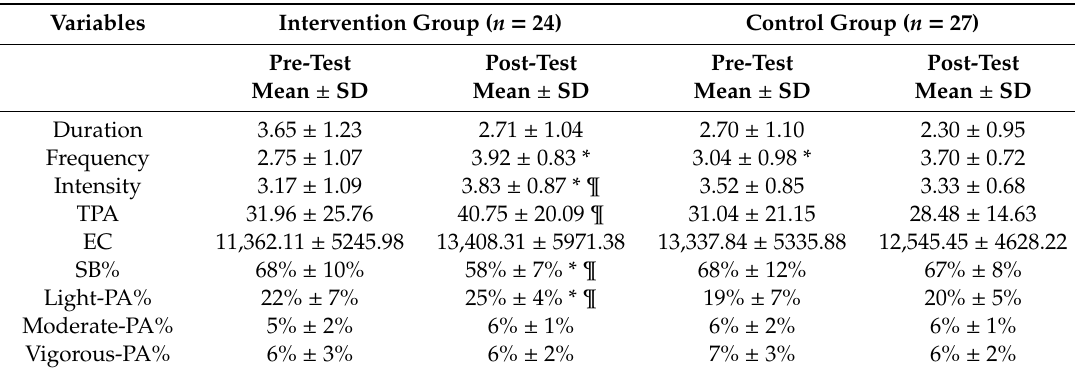
Table 4. Results of behavioral indices between the two groups at baseline and follow-up. Variables Intervention Group ( n = 24) Control Group ( n = 27) Pre-Test Post-Test Pre-Test Post-Test Mean ± SD Mean ± SD Mean ± SD Mean ± SD Duration 3.65 ± 1.23 2.71 ± 1.04 2.70 ± 1.10 2.30 ± 0.95 Frequency 2.75 ± 1.07 3.92 ± 0.83 * 3.04 ± 0.98 * 3.70 ± 0.72 Intensity 3.17 ± 1.09 3.83 ± 0.87 * ¶ 3.52 ± 0.85 3.33 ± 0.68 TPA 31.96 ± 25.76 40.75 ± 20.09 ¶ 31.04 ± 21.15 28.48 ± 14.63 EC 11,362.11 ± 5245.98 13,408.31 ± 5971.38 13,337.84 ± 5335.88 12,545.45 ± 4628.22 SB% 68% ± 10% 58% ± 7% * ¶ 68% ± 12% 67% ± 8% Light-PA% 22% ± 7% 25% ± 4% * ¶ 19% ± 7% 20% ± 5% Moderate-PA% 5% ± 2% 6% ± 1% 6% ± 2% 6% ± 1%